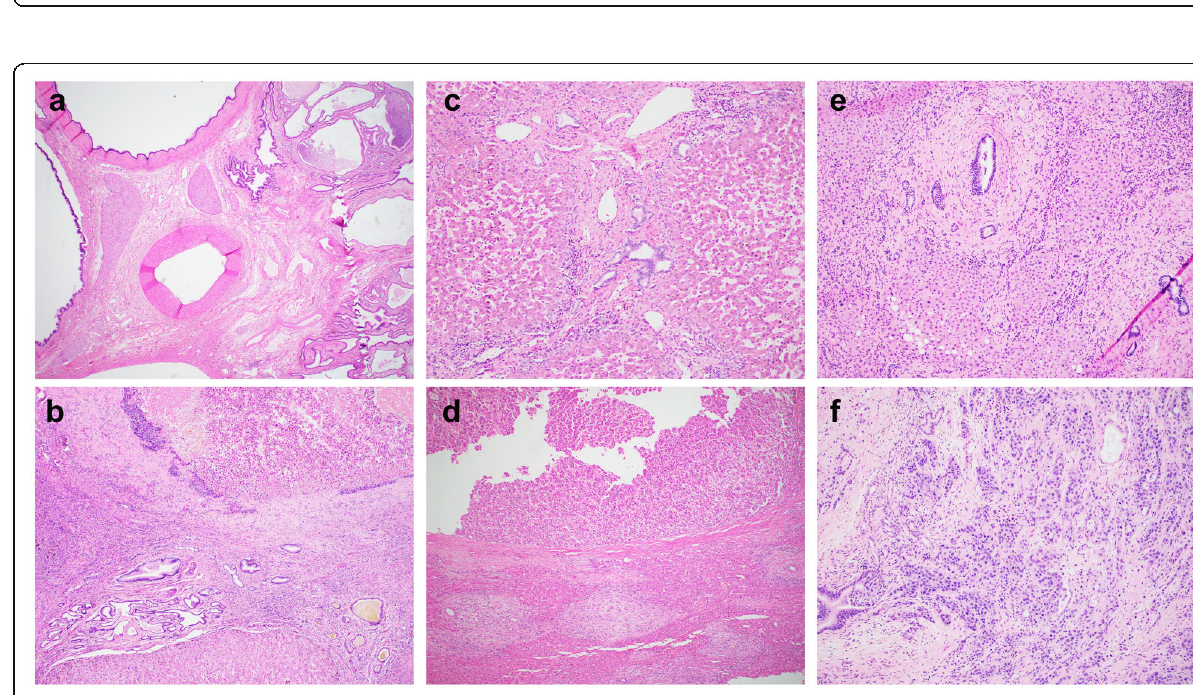
Fig. 3 Paucity of intrahepatic bile ducts in a patient with nephronophthisis (case 14). a-b The liver shows thin delicate portal/periportal fibrosis and eccentrically located portal veins with dilatation and herniation. Bile duct is missing in approximately 68% portal tracts. c-d In one portal tract there are residual bile ducts highlighted by CK19 immunohistochemistry, somewhat resembling ductal plate malformation. Magnification: a-b : 100X, c-d : 200x